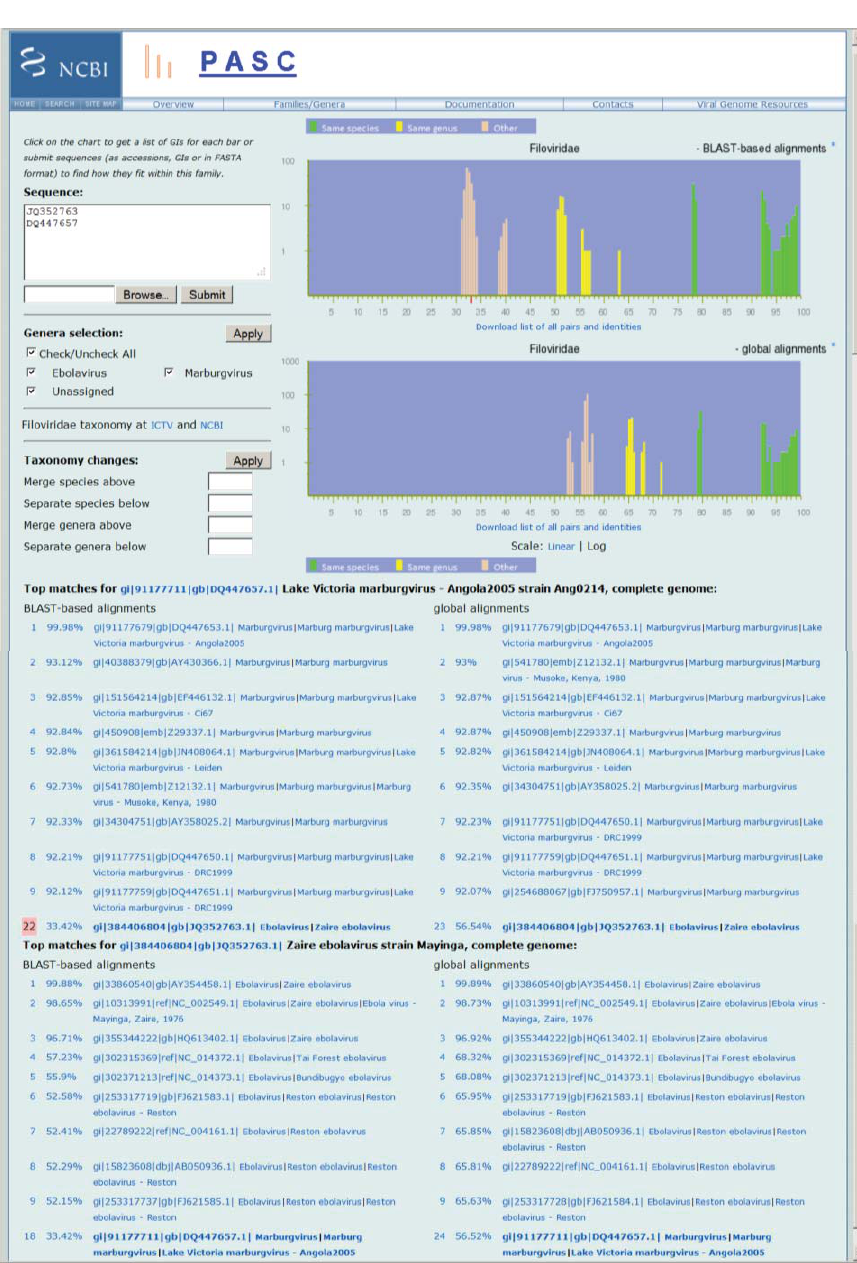
Figure 1. Frequency distribution of pairwise identities for the complete genome sequences of filoviruses, and the application in classifying newly sequenced viruses. The two plots represent results obtained by the BLAST-based alignments and global alignments respectively. The green, yellow and peach bars in the plots represent pairs of genomes that are assigned to the same species, different species but in the same genus, and different genera respectively in the current National Center for Biotechnology Information (NCBI) Taxonomy Database. The top matches for each input genome (JQ352763 and DQ447657) to the existing genomes in GenBank and other input genome are listed, and their pairwise identities are shown. The small red bar on the X-axis of the top plot indicates the percentage of identity of the selected pair (#22 which is highlighted). Not all virus species names listed reflect the most recent International Committee on Taxonomy of Viruses (ICTV) species